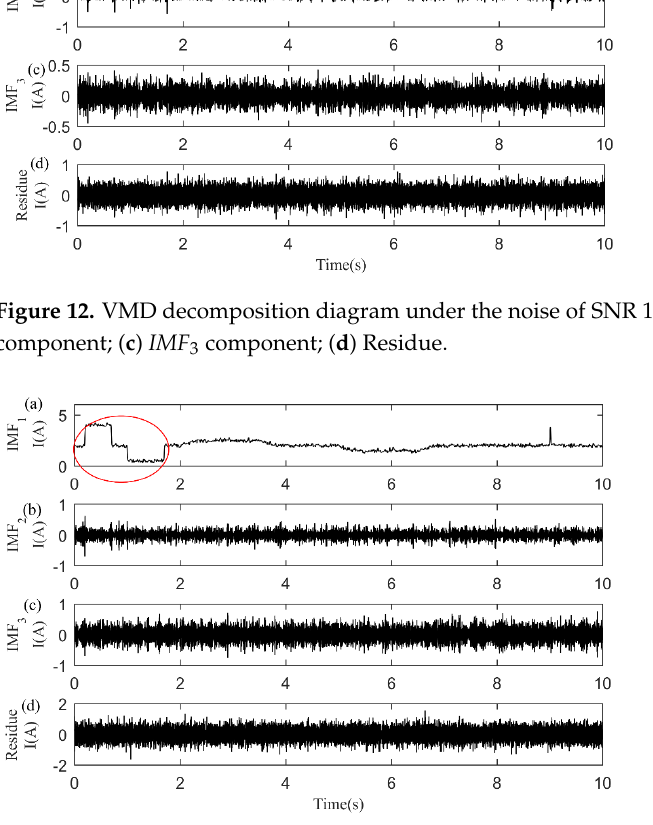
Figure 14. EEMD decomposition diagram under the noise of SNR 10. ( a ) IMF 1 component; ( b ) IMF 2 component; ( c ) IMF 3 component; ( d ) IMF 4 component; ( e ) Residue.